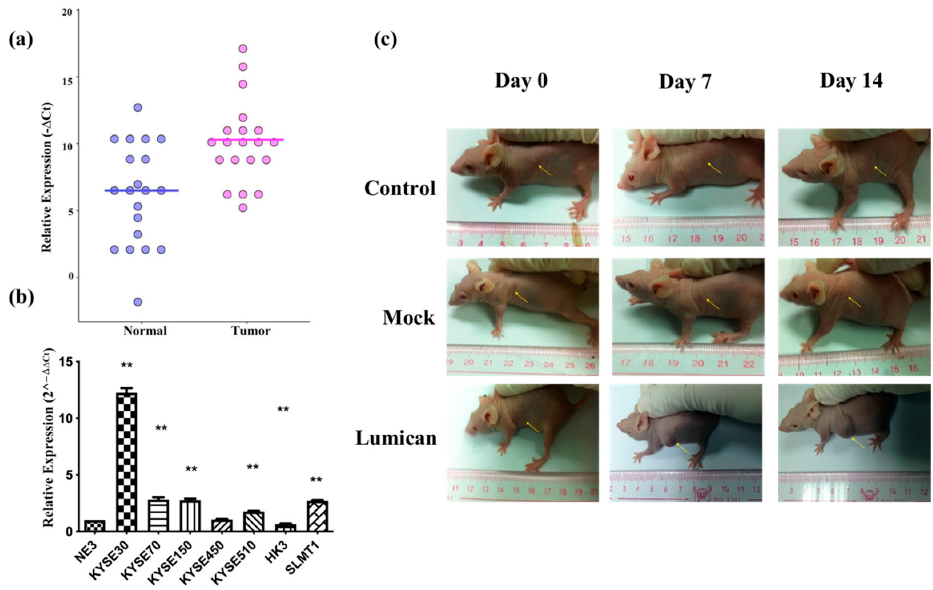
Figure 4. Lumican is usually overexpressed in tumor tissue and several kinds of cancer cell lines, and promotes tumorigenesis. ( a ) Relative Lumican expression level in tumor tissue and adjacent normal tissue isolated from cancer patients. β -actin was applied as the reference gene to normalize the Lumican expression. N = 20. ** p < 0.01; ( b ) relative Lumican expression levels in seven cancer cell lines and the nontumor cell line (NE3). The relative Lumican expression level was determined by comparison with NE3, after being normalized with the expression of β -actin. ** p < 0.01; ( c ) images of subcutaneous tumor formation in the nude mice with the injection of NIH 3T3 parental cells, Mock vector, or Lumican gene transfected NIH 3T3 cells on day 0, day 7, and day 14, respectively, after injection.